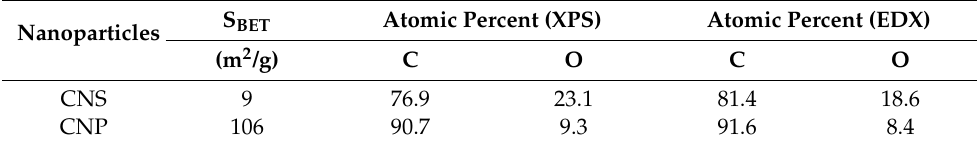
Table 1. S BET , XPS and EDX results of CNS and CNP dry